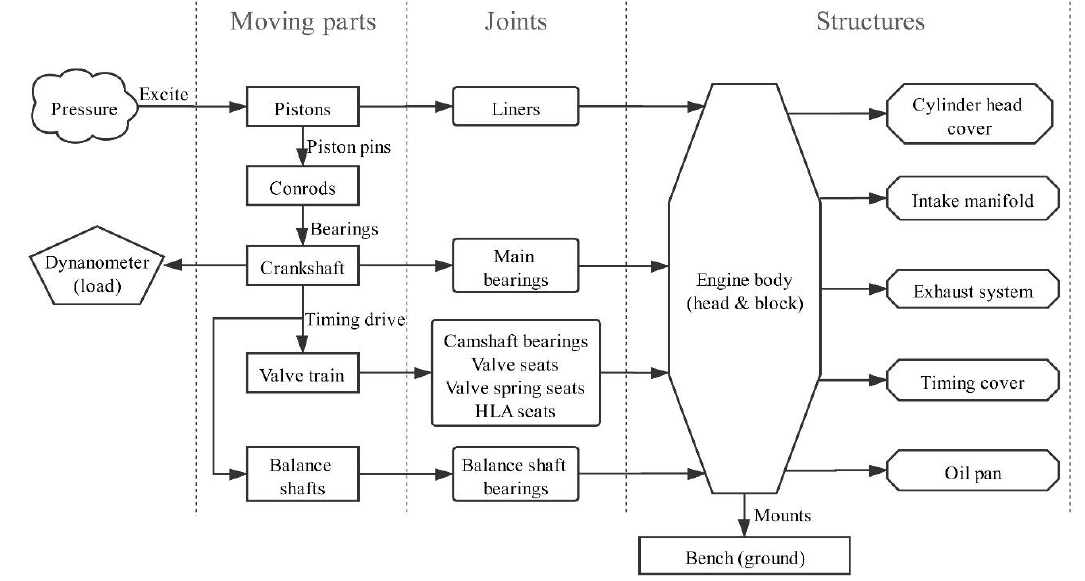
Figure 5. Schematic diagram of the engine model structure.